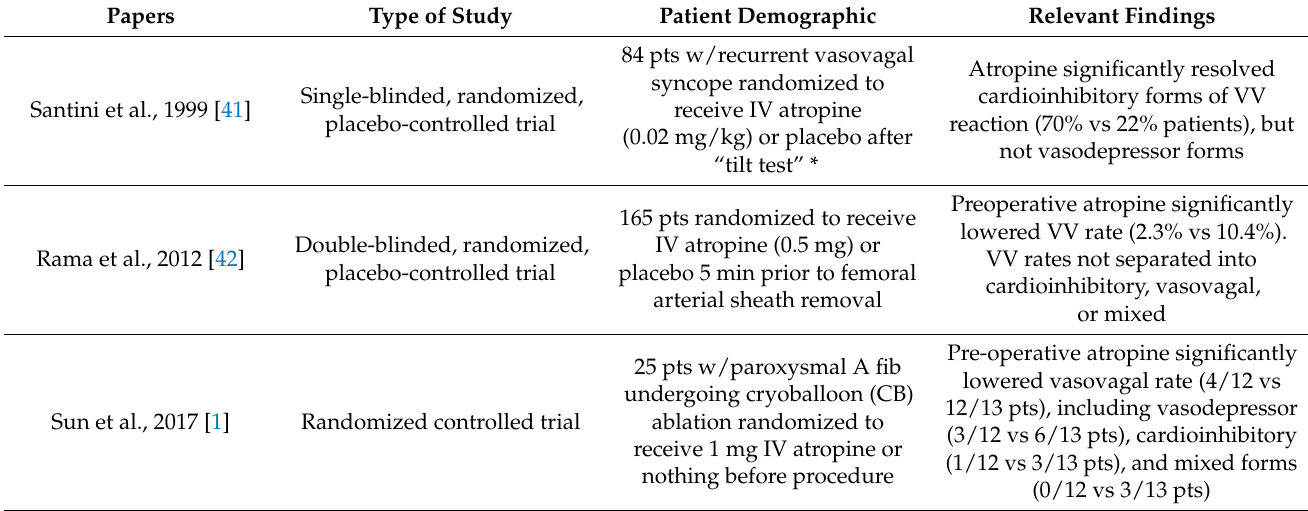
Table 5. Antimuscarinic use for treating and preventing vasovagal